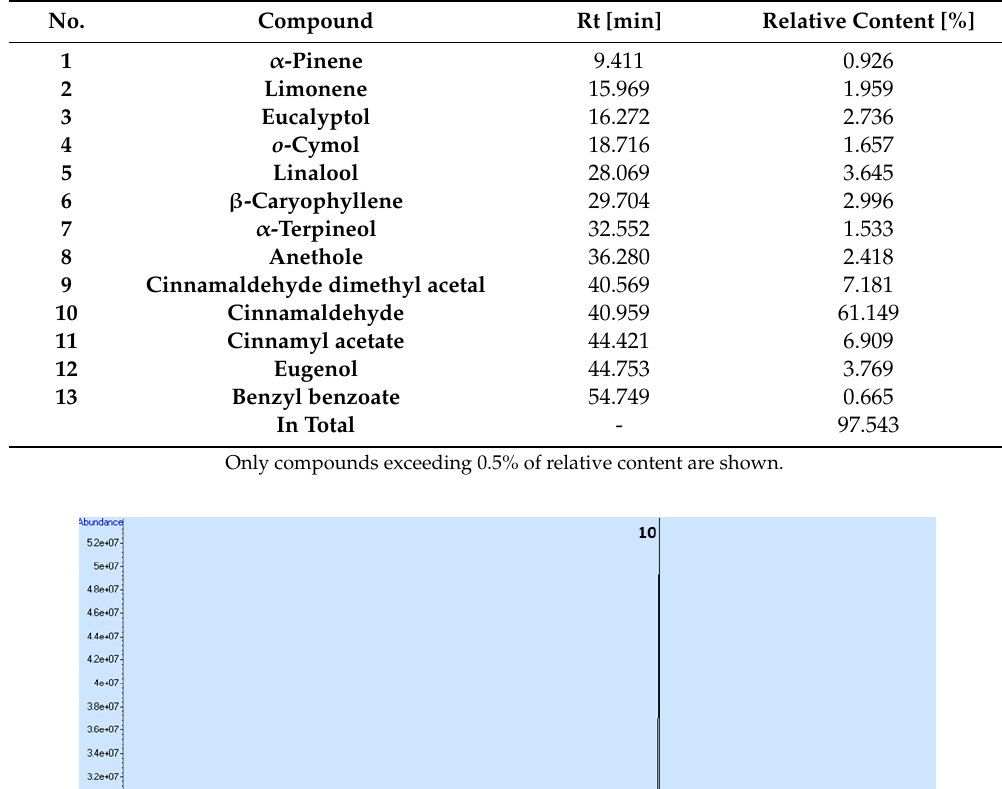
Table 1. Relative abundance of the major compounds in C. zeylanicum essential oil.